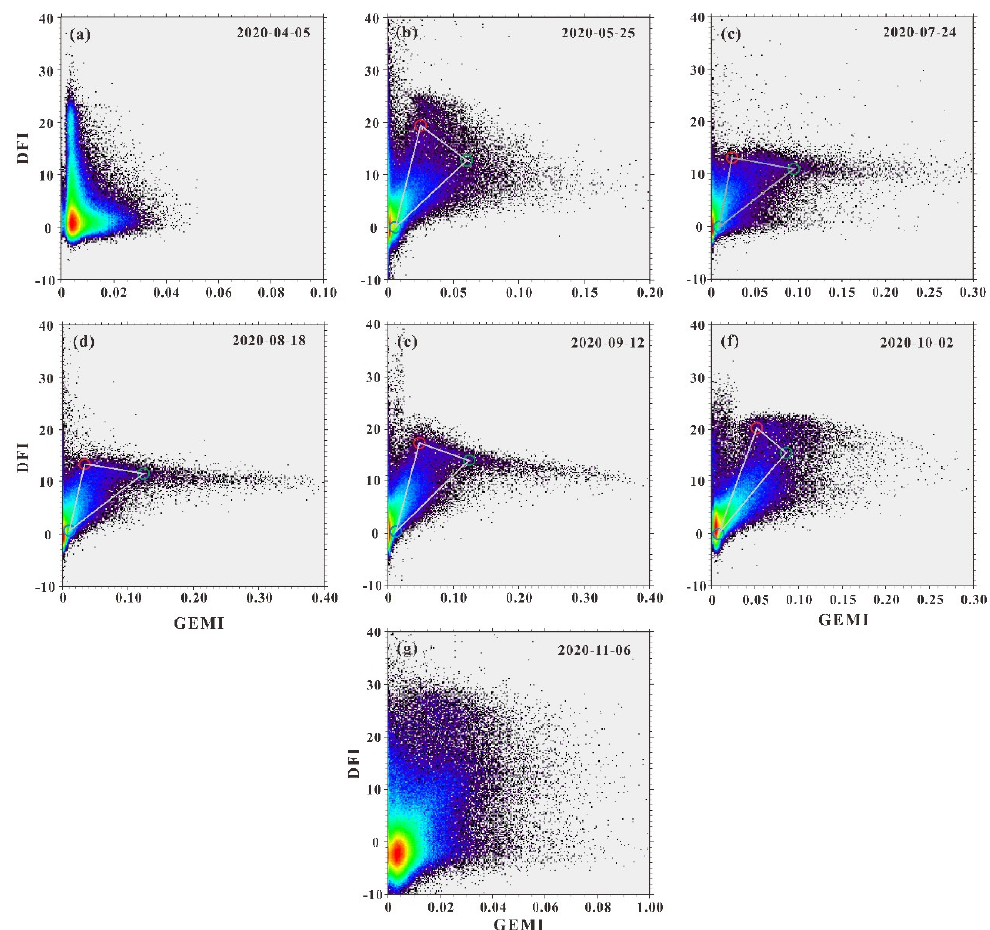
Figure 7. Response spaces of the Sentinel-2A reflectance spectral defined by the GEMI and DFI for seven dates in 2020. The green, red and blue circle indicate the position of the PV, NPV and BS end members, respectively (and form triangles). The colors indicate the point density from blue (low density) to dark red (high density). ( a ) 5 April 2020, ( b ) 25 May 2020, ( c )